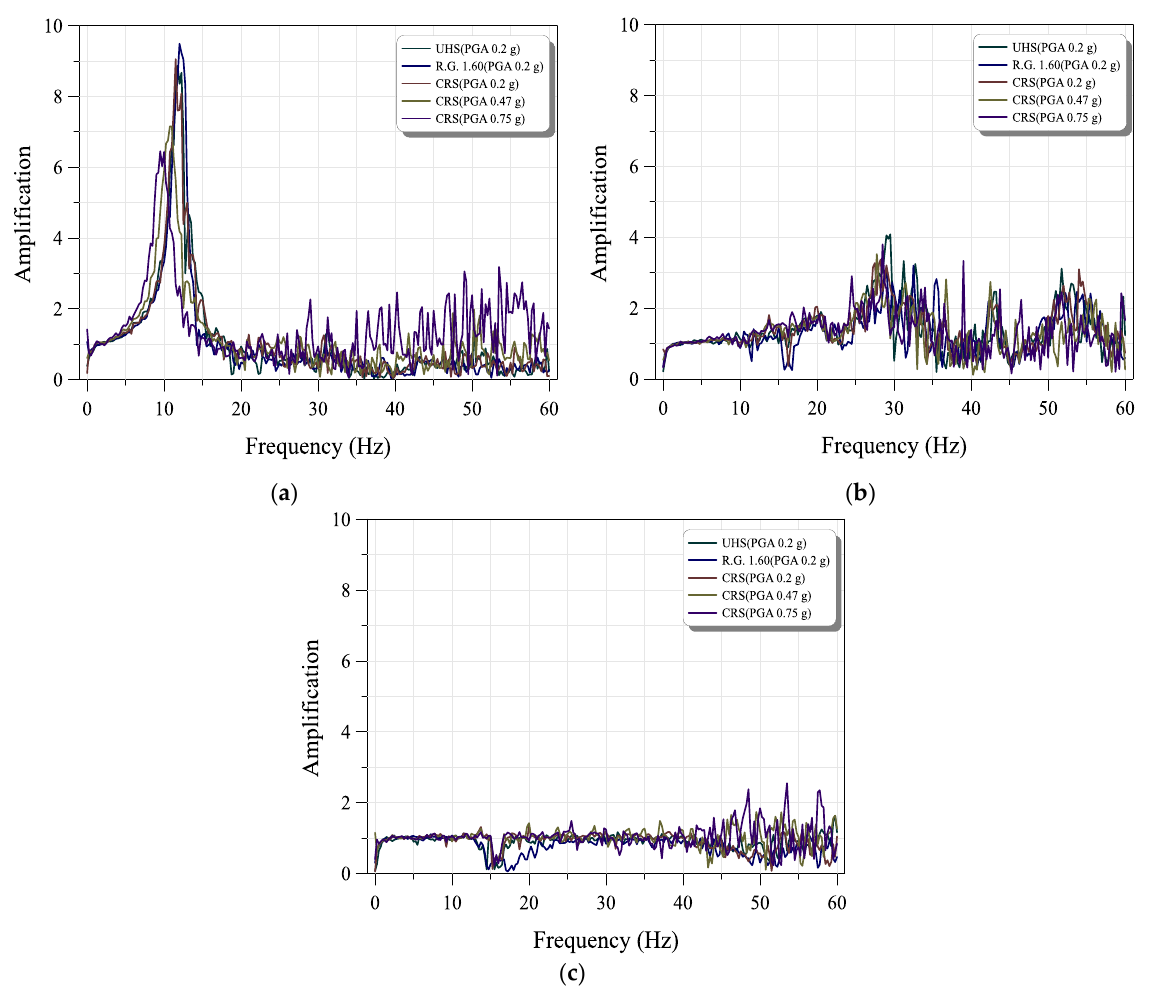
Figure 10. Comparison of in-structure amplifications depending on input motion: ( a ) side to side, ( b ) front to back, and ( c ) vertical.